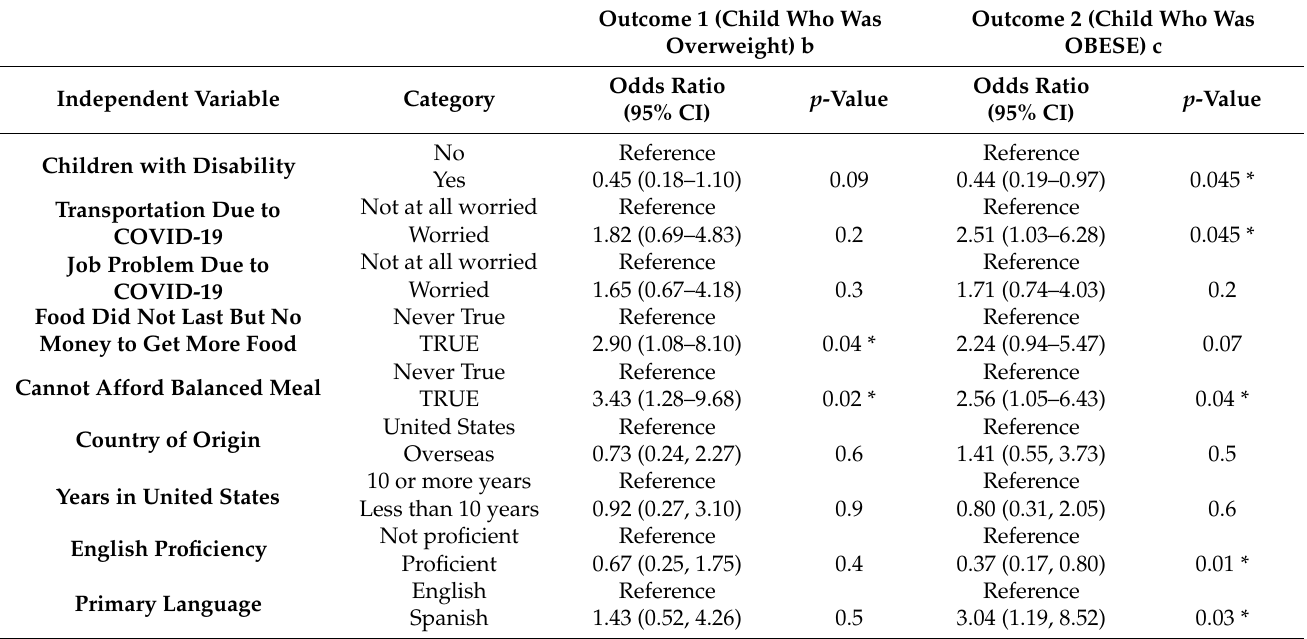
Table 3. Odds of Abnormal Weight by Various Descriptive and Food Insecurity Variables. Outcome 1 (Child Who Was Outcome 2 (Child Who Was Overweight) b OBESE)